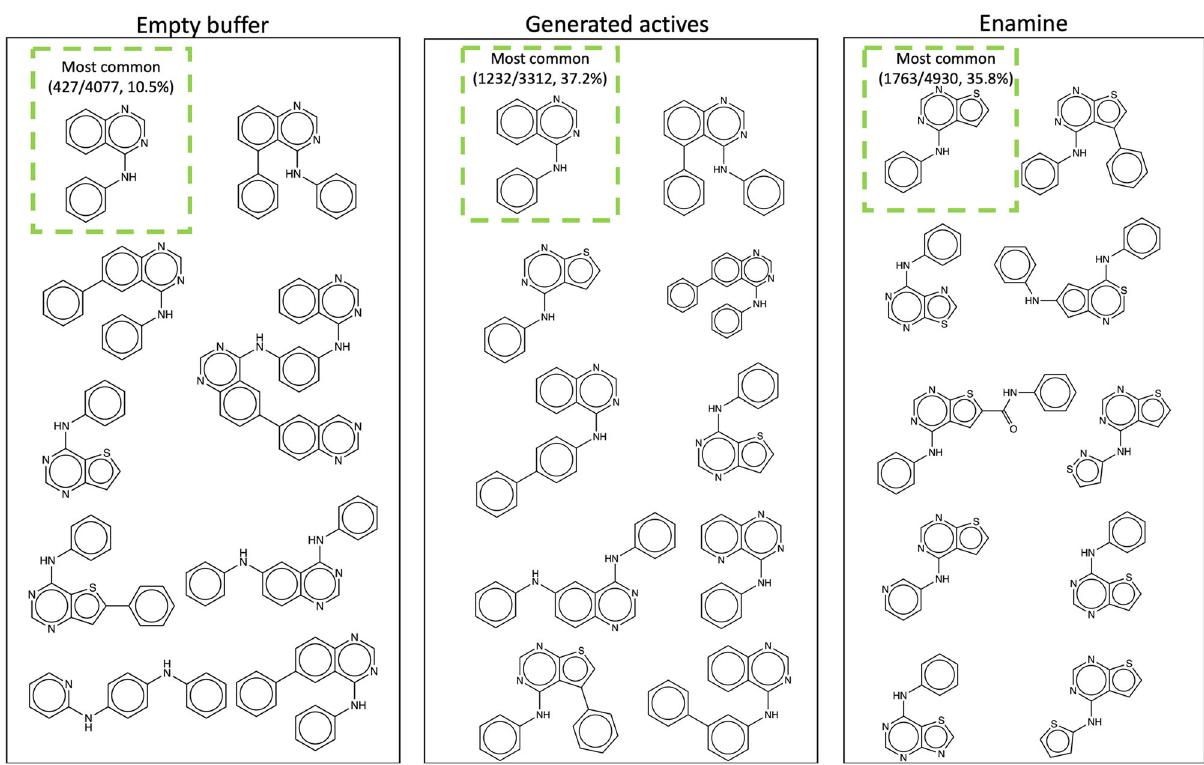
Fig. 4 The 12 most common Bemis-Murcko scaffolds for models trained from different libraries. Three replay libraries were tested: an empty replay library (Empty buffer), the replay library from the model (generated actives), and the Enamine library selected as above (Enamine). Models were trained for 20 epochs with 15 iterations of policy gradient, 10 iterations of experience replay, and 20 iterations of fi ne-tuning per epoch. Scaffolds are sorted with decreasing counts from left to the right, then from top to bottom. The most common scaffolds had counts and percentages as follows: 427 out of 4077 predicted active molecules (10.5%) for the empty buffer, 1232 out of 3312 (37.2%) for the generated actives, and 1763 out of 4930 (35.8%) for the Enamine library.